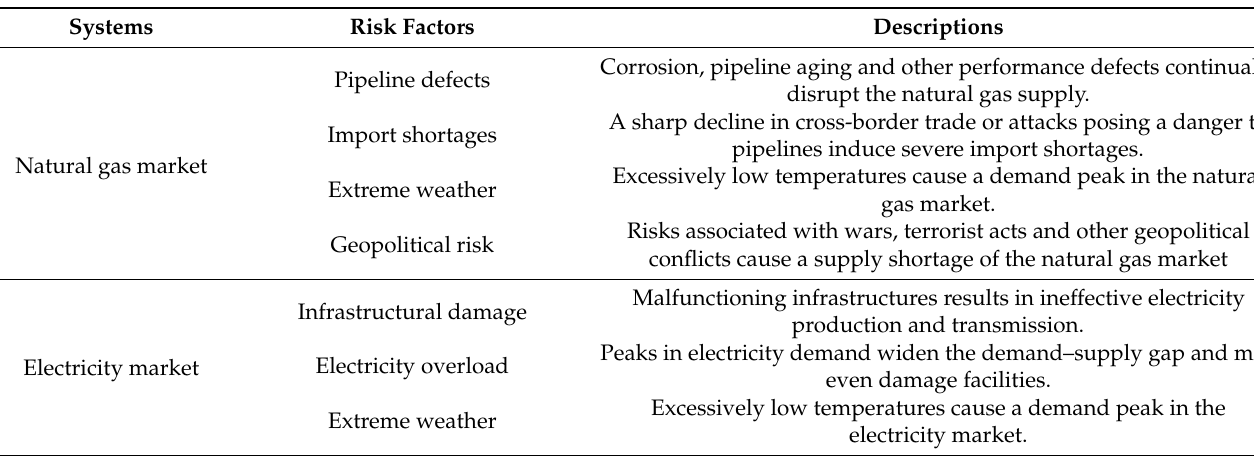
Table 1. Prominent risk factors and their